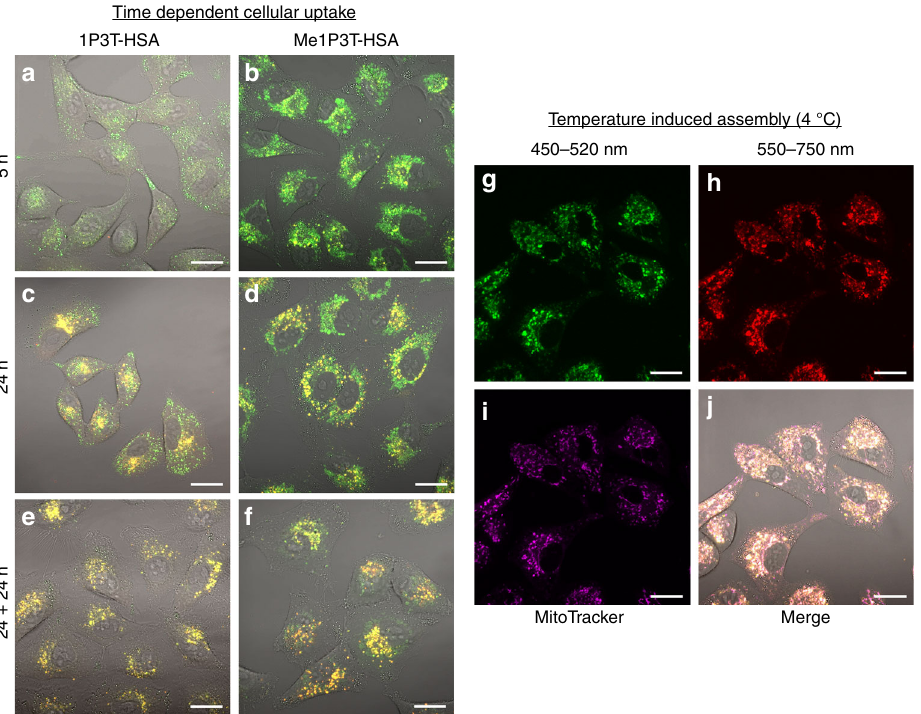
Fig. 9 Time dependent and temperature induced self-assembly. A549 cells were treated with 1P3T-HSA a , c and Me1P3T-HSA b , d at 15 µ M for 5 h and 24 h. e , f For an independent set of cells, the medium containing the samples was removed and added pure DMEM and incubated a further 24 h. Progression of free molecules (green) into aggregates (red, co-localized as yellow) can be clearly observed in a time dependent manner for both oligothiophene analogues. g – j A549 cells were pre-treated with ba fi lomycin and incubated with Me1P3T-HSA at 15 µ M for 24 h (37 °C, 5% CO 2 ). The cells were stained with MitoTracker Deep Red (purple) and they are incubated at 4 °C separately for a further 2 h and imaged via confocal laser scanning microscopy. The control experiment is shown in Fig. 8i – l. Scale bar = 20 µ m. The molecular form (green) of Me1P3T was locked in the mitochondria and forced to self- assemble into superstructures (red) by decreasing the ambient temperature. Co-localization of free molecules (green), assemblies (red) and MitoTracker (purple) represented in magenta/pink